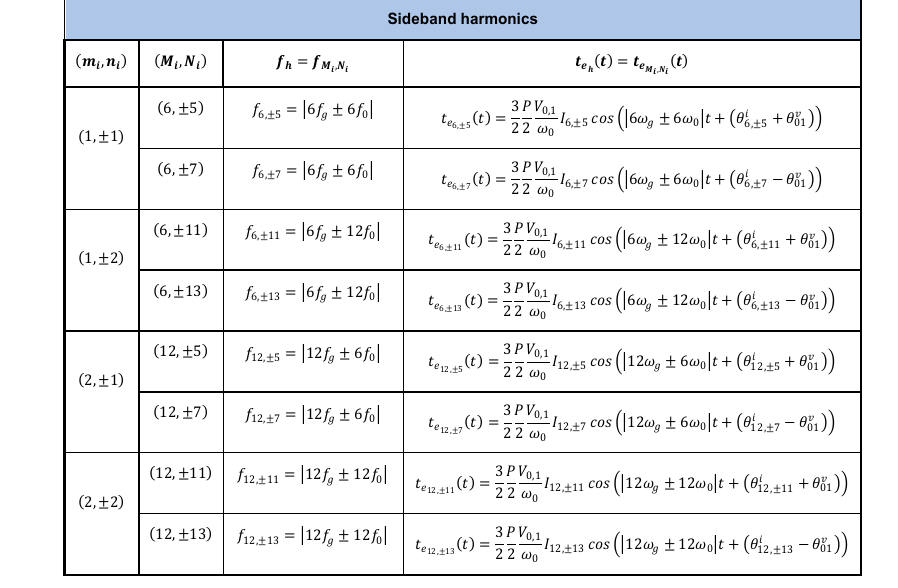
Figure 6. Harmonic families in a 6/6-pulse LCI system: sideband families.